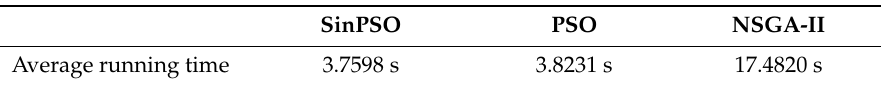
Table 7. Algorithm running